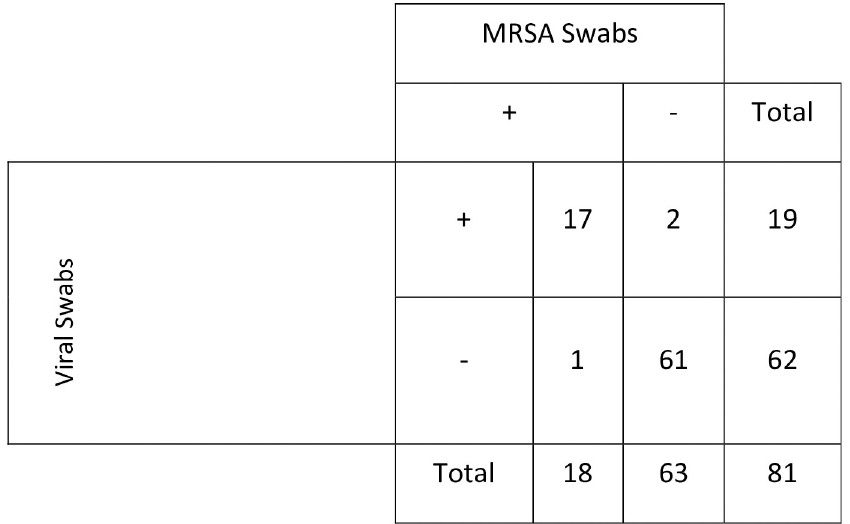
Fig 1. Test esults on the Simplexa 1 COVID-19 Direct Kit (DiaSorin) comparing viral swabs and MRSA